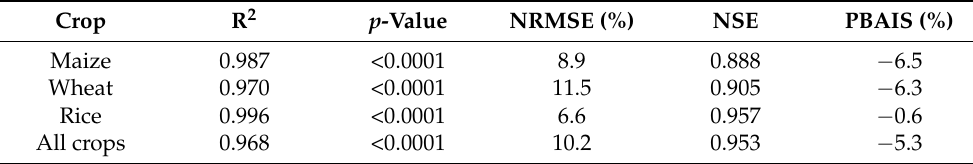
Table 2. Validation parameters of retrieved phenological